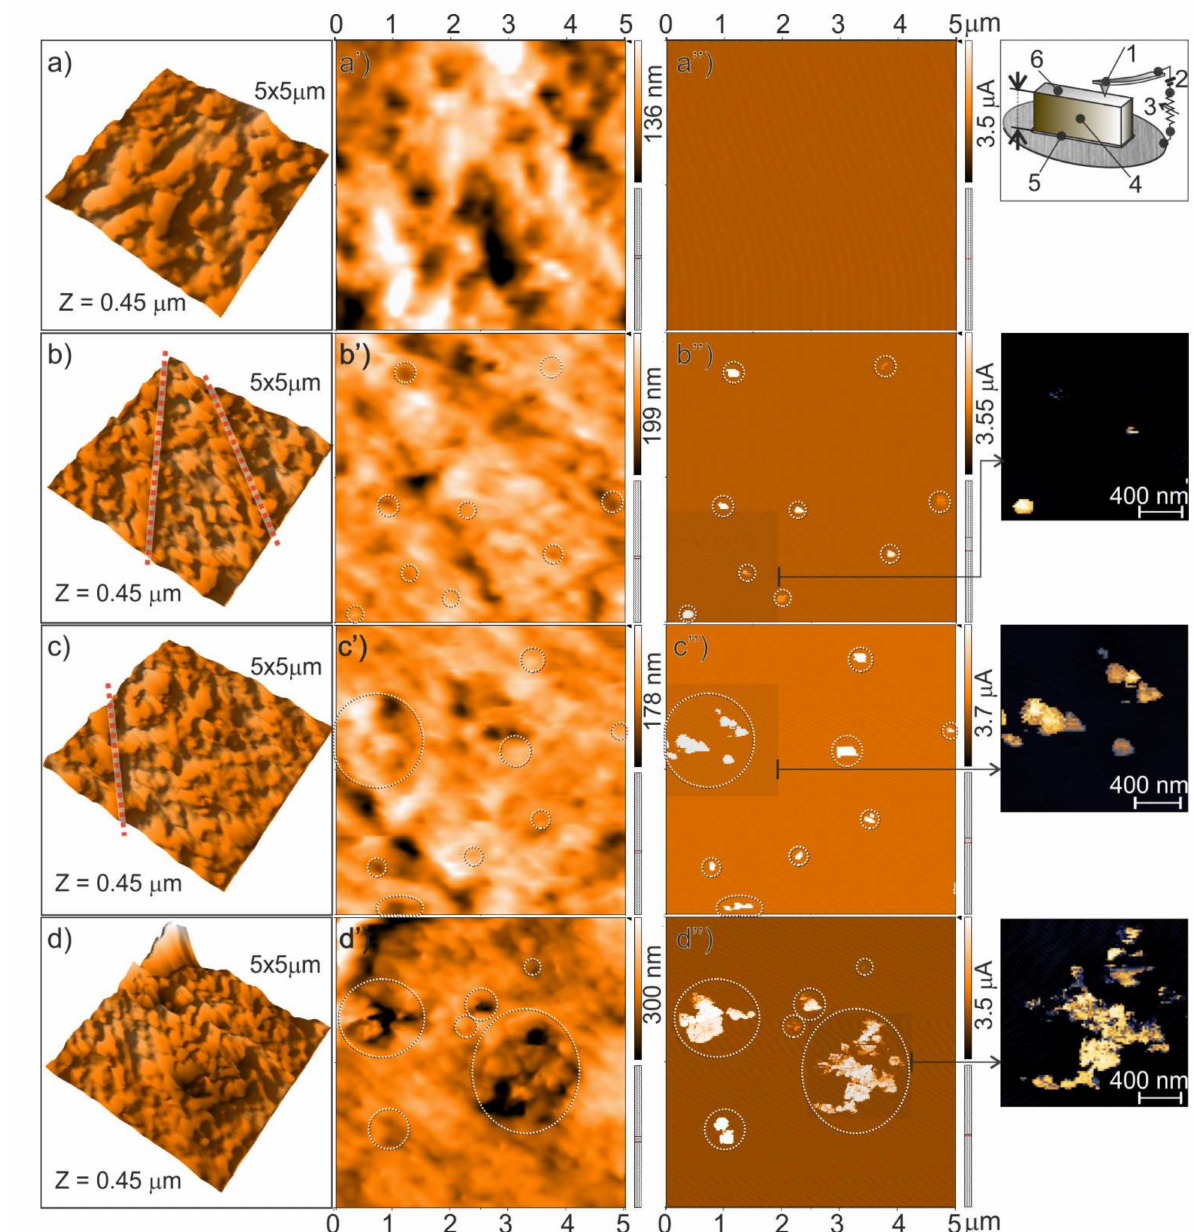
Figure 5. 5 × 5 µ m AFM images and current maps of CB/PA66 polymer composites with different CB content: 9 ( a – a” ), 17 ( b – b” ), 21 ( c – c” ), and 27 wt. % ( d – d” ), respectively; 3D AFM images: ( a – d ), related topographic signals: ( a – d ), as compared to current maps: ( a” – d” ), respectively, acquired in C-AFM mode. In the insets, schematic representation of the setup for simultaneous topography/current mapping (top inset; 1: conductive cantilever/probe, 2: DC V source, 3: resistor; 4: sample, 5: Ag paste, 6: polished surface. The thickness of the specimen is c.a. 1–1.5 mm) and topography/current mixed signals in selected areas of ( b” – d” ), are also